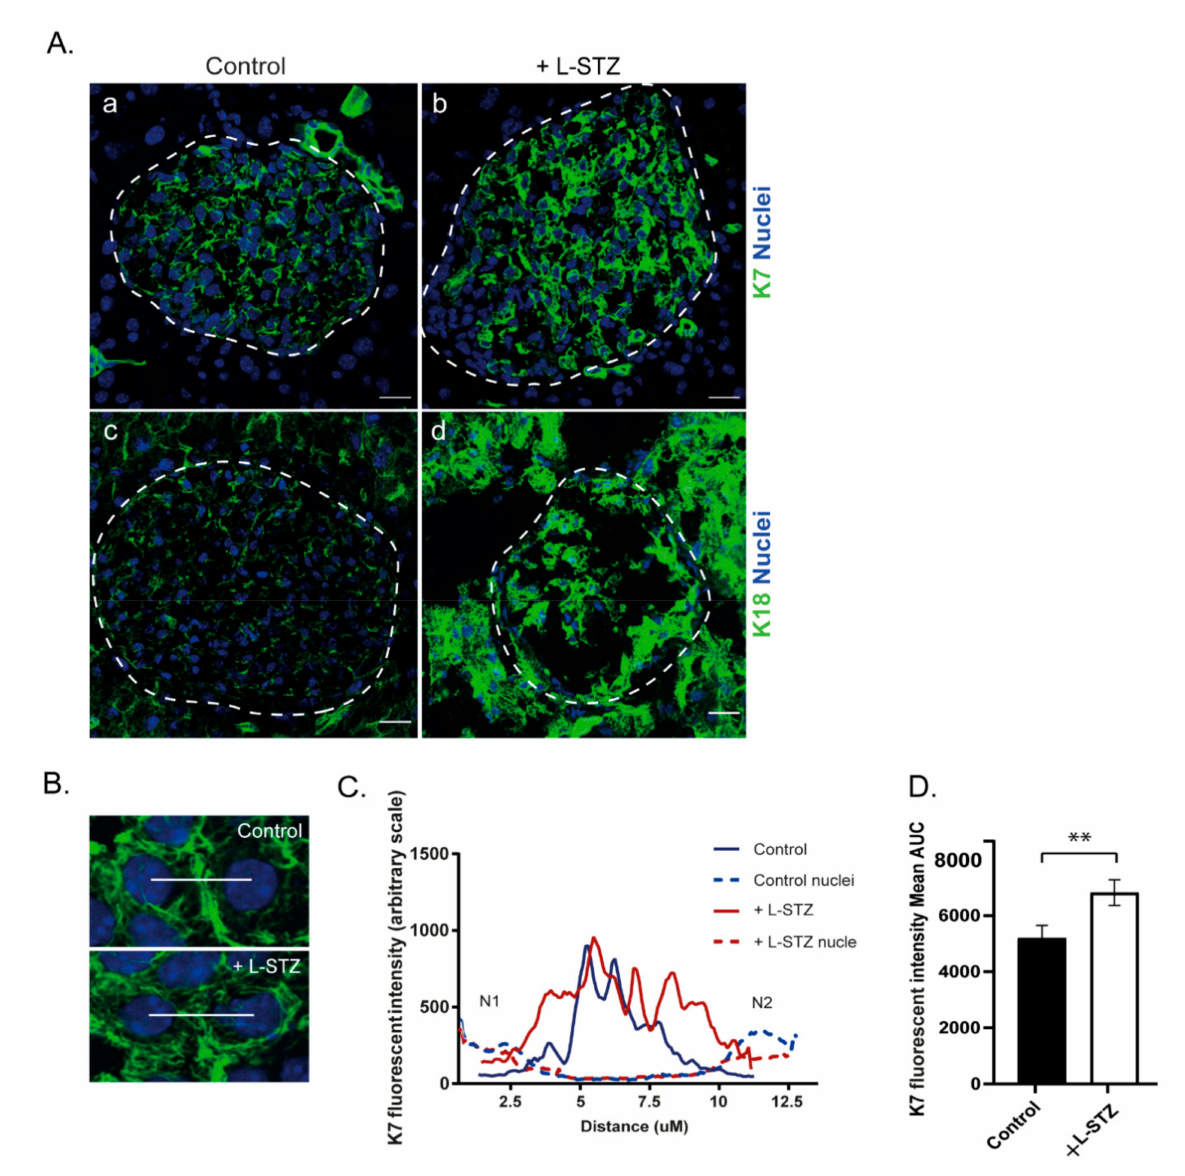
Figure 6. K7 is upregulated and K7 cytoplasmic filaments become more prominent in pancreatic islets upon low-dose streptozotocin treatment. ( A ) Pancreatic tissue sections from control and diabetic low-dose streptozotocin (+L-STZ) treated mice were immunostained for K7, K18 (green) and nuclei (blue). Images show upregulation of K7 ( b ) as well as K18 ( d ) in pancreatic islets upon L-STZ treatment compared to control ( a , c ). Islets are outlined by dotted lines. Scale bar = 20 µ m. n = 2 mice per group with minimally 10 islets analyzed per mouse. ( B ) K7 filament localization in islet β -cells, is analyzed by profiling the K7 intensity along a line connecting the center of nuclei of two neighboring cells in L-STZ treated and control mouse islets. ( C ) Graph representing the K7 intensity, between the nuclei of islet β -cell pairs, n = 5 β -cell pairs. ( D ) K7 levels were significantly higher in islets of L-STZ treated mice compared to control demonstrated by the mean area under curve (AUC) for K7, n = 50 β -cell pairs. ** p < 0.01, using the Student’s t-test. Error bars represent mean ±